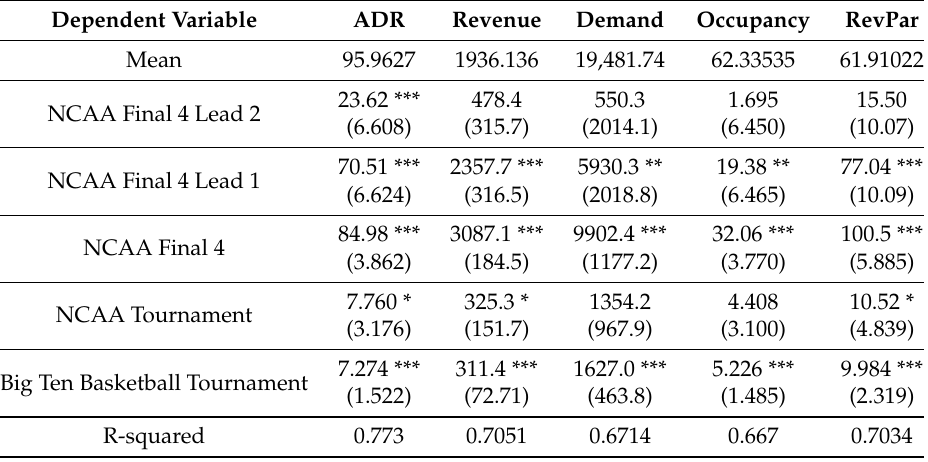
Table 10. The impact of NCAA Basketball Final 4, NCAA Tournament, and Big Ten Basketball Tournament on the hotel